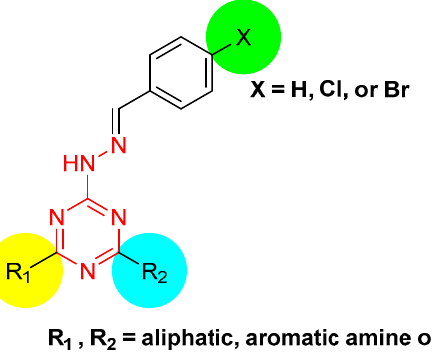
Figure 1. Structure of the novel synthesized s -triazine compounds.